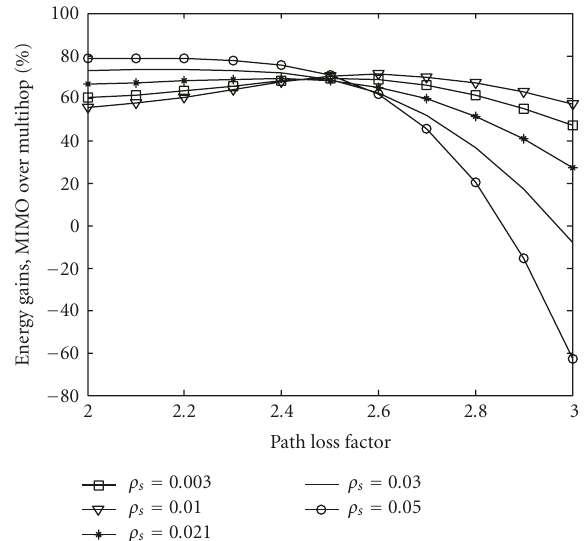
Figure 13: Energy gains inserted with CN selection for D = 40m and di ff erent network